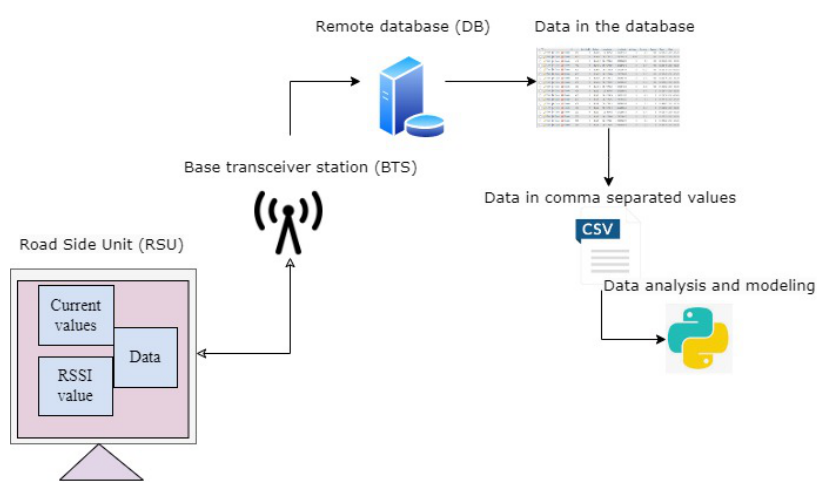
Figure 5. System architectural diagram. Table 2. Description of RSSI and current consumption by RSU and location.